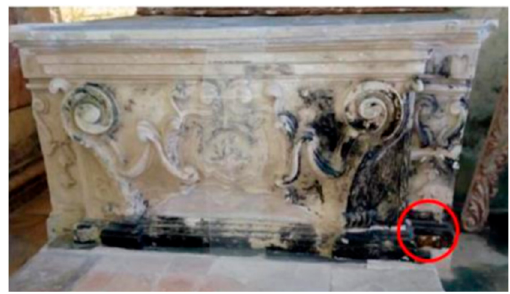
Figure 2. Black crusts on the altar of St. Joseph in the San Pietro Barisano church.